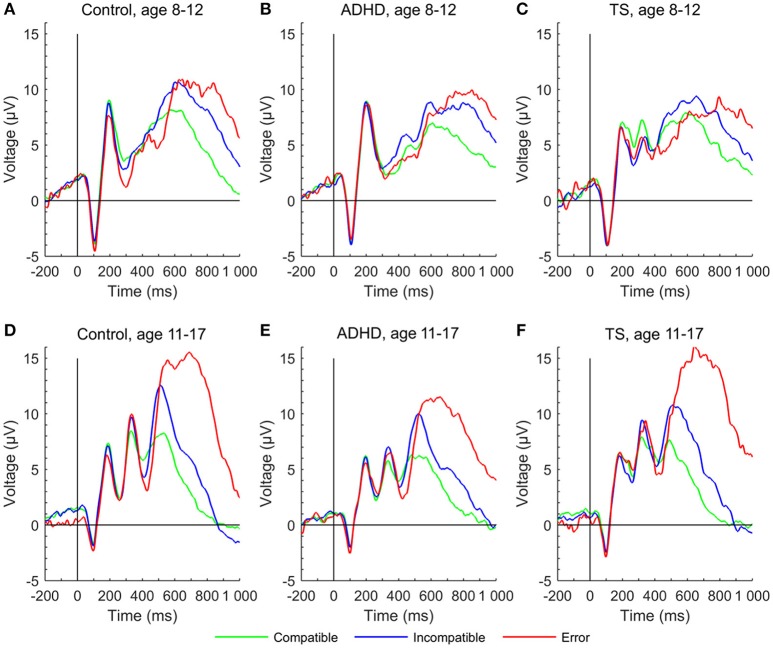
P2, early P3, and late P3 in stimulus-locked event-related potentials at a central region of interest to compatible (green), incompatible (blue) and erroneous trials (red) of the Flanker task for each group at first and second assessment. (A) control group at age 8–12 years, (D) control group at age 11–17 years, (B) ADHD group aged 8–12 years, (E) ADHD group aged 11–17 years, (C) TS group at age 8–12 years, (F) TS group at age 11–17 years.